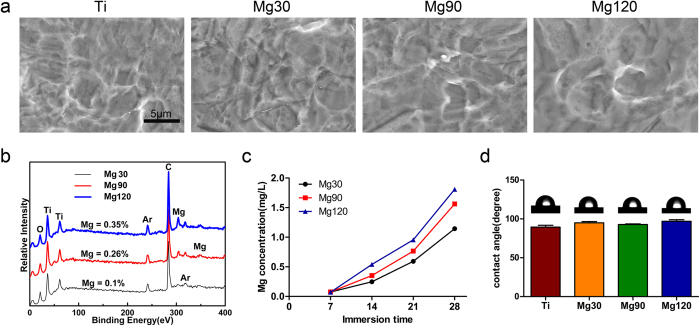
(a) Scanning electron microscopy (SEM) images of titanium (Ti) and magnesium plasma immersion ion implantation (Mg PIII)-treated titanium with different doping time (Mg30, Mg90, Mg120), (b) X-ray photoelectron spectroscopy (XPS) spectra, (c) Mg concentrations released from Mg PIII-treated titanium at days 7, 14, 21 and 28, (d) Water contact angles of the samples. (Statistically significant difference: *p < 0.05; **p < 0.01; triplicate).